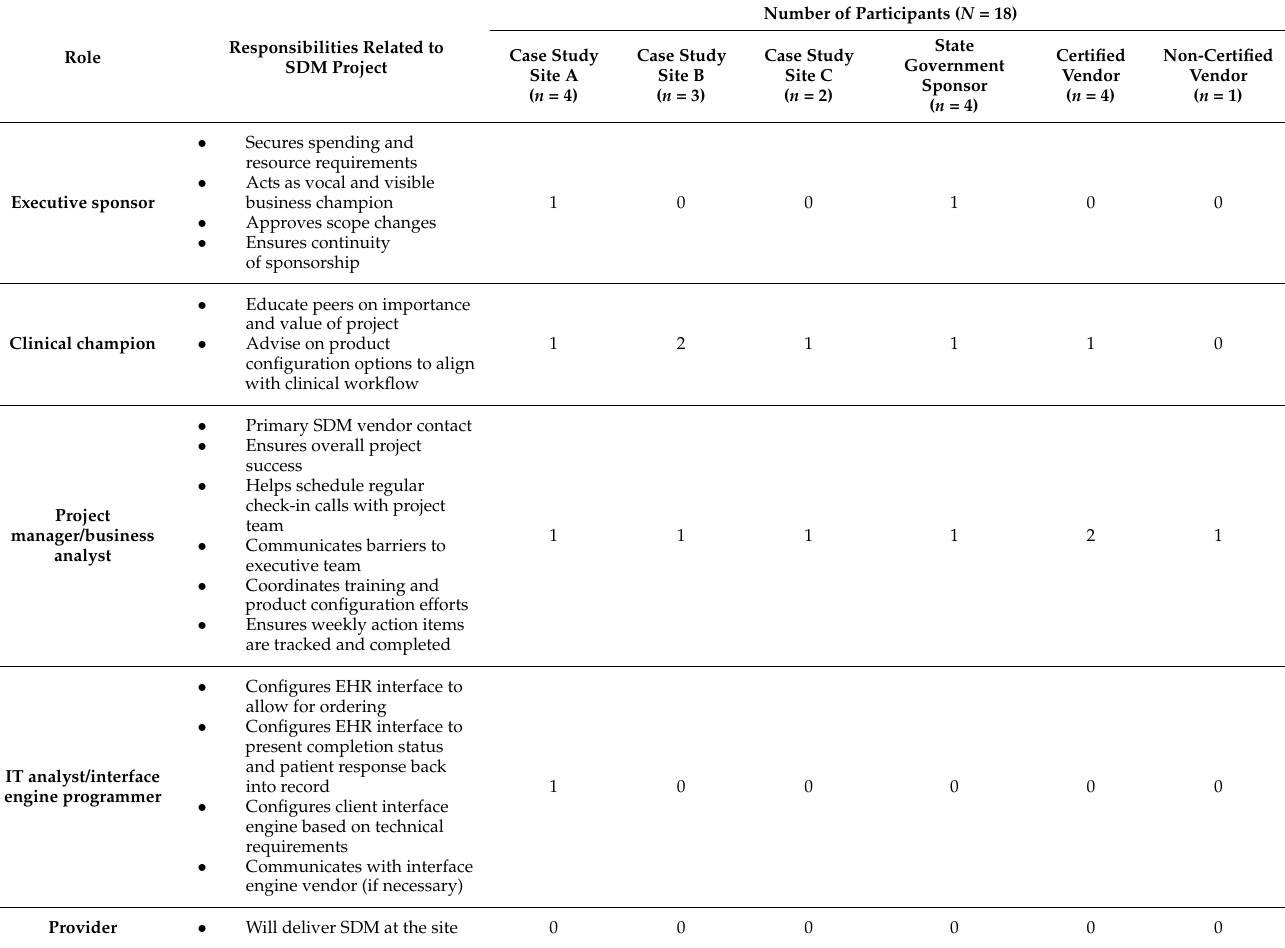
Table A1. Interview participant